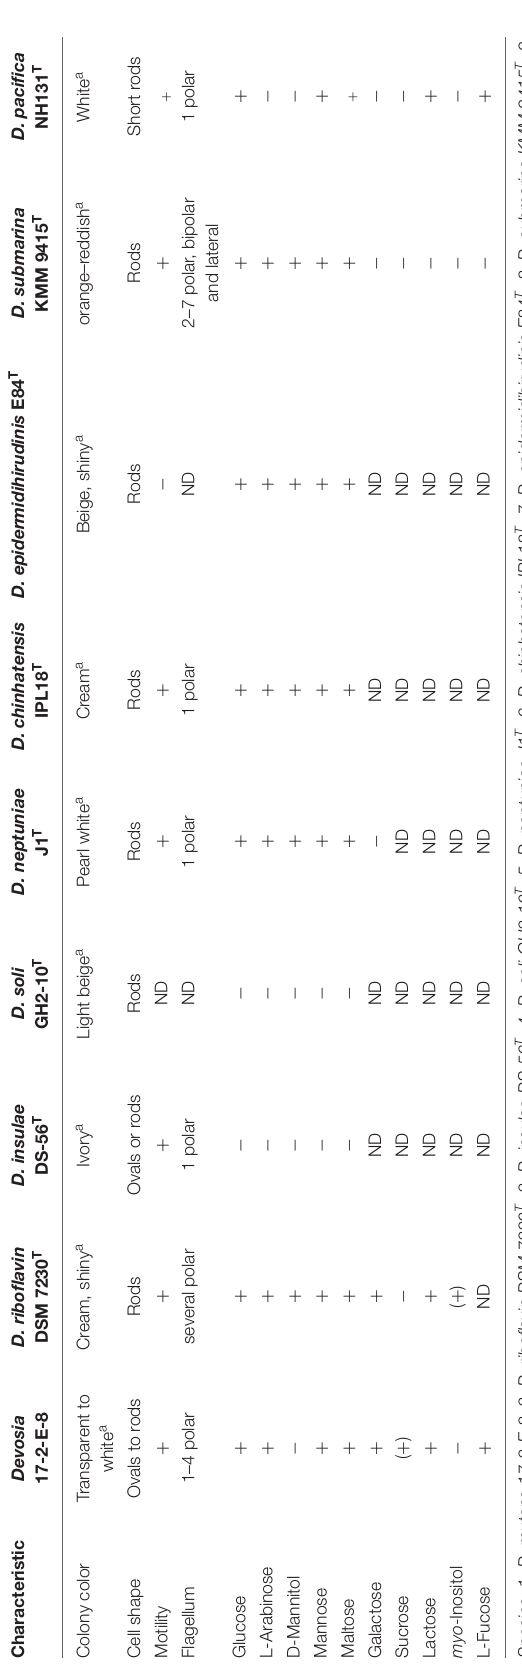
Metabolic profiling indicated that isolate 17-2-E-8 utilized α - D -glucose, α - D -lactose, maltose, D -mannose, L - arabinose, D -cellobiose, L -fucose, D -galactose, gentiobiose, and melibiose, but not D -fructose, lactulose, or D -sorbitol ( Table 5 ). The bacterium thrived in the presence of D , L -lactic, D -gluconic, hydroxybutyricacid, and D -saccharic acids while growth was inhibited in the presence of acetic, citric, formic, malonic, propionic, and succinic acids, respectively.